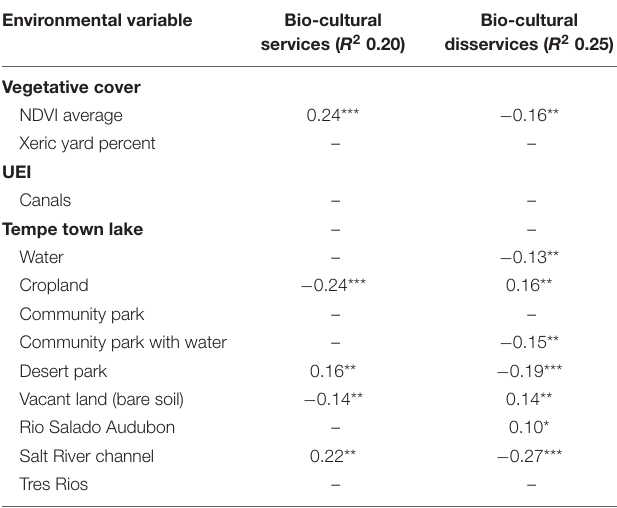
Standardized beta values for each model are reported with significance indicated by “*,” “**,” and “***” representing p < 0.05, p < 0.01, and p < 0.001. Beta values for non-significant variables not included.